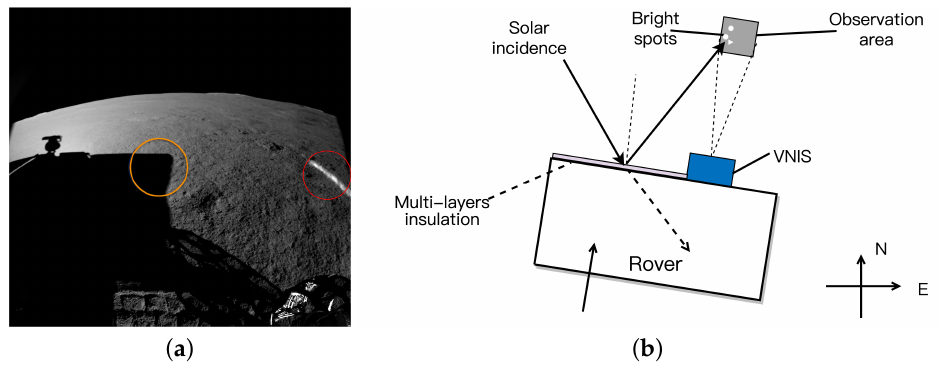
Figure 1. Image obtained using the obstacle avoidance camera on the fourth lunar day of Chang’E-4 (CE-4) [3]. ( a ) The area marked by the red circle shows the stray light introduced by the specular reflection of the multi-layer insulation (MLI). The area marked by the yellow circle indicates the projection of the shadow of the rover onto the lunar surface. ( b ) Light paths of bright spots introduced by MLI specular